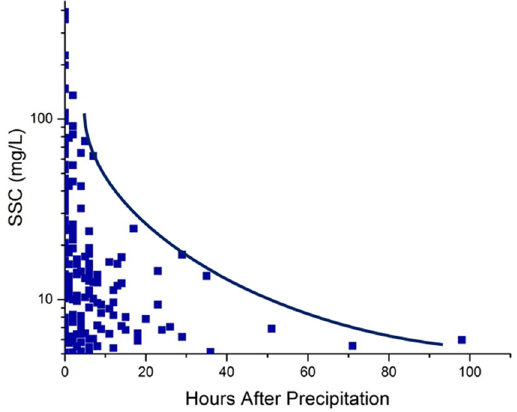
Figure 4. Suspended sediment concentrations measured during base flow conditions at the Allen Creek #1 monitoring station between March 2007 and September 2011. Nearly 85% of the samples exhibited concentrations <5 mg/L; more than 99% exhibited concentration <10 mg/L.